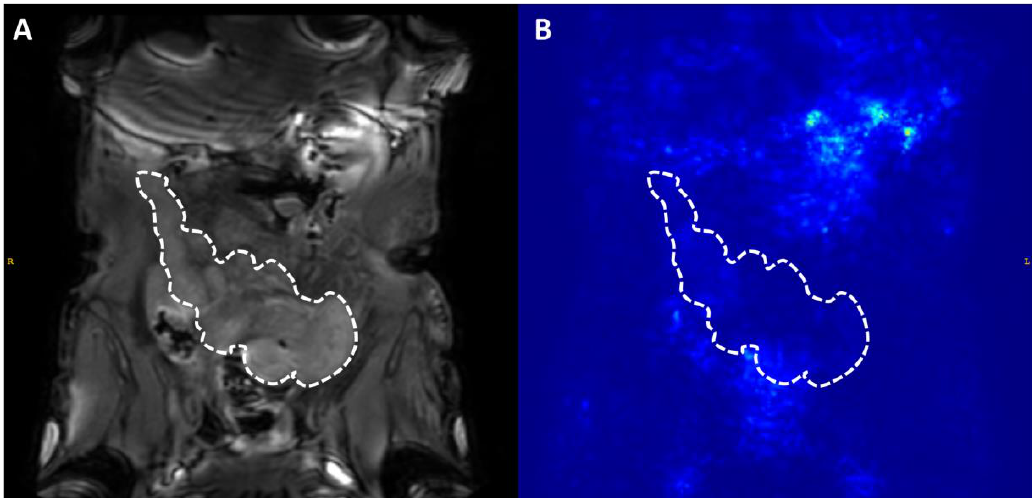
Figure 6. Dynamic cine MRI small bowel imaging was used to quantify small bowel motility. Regions of interest drawn on anatomical imaging ( A ) were colocalised to motility maps (the standard deviation of the determinant of pixel’s Jacobian) value ( B ). Averages were drawn across multiple slices for entire small bowel coverage. Small bowel motility in this example was 0.21 arbitrary units.